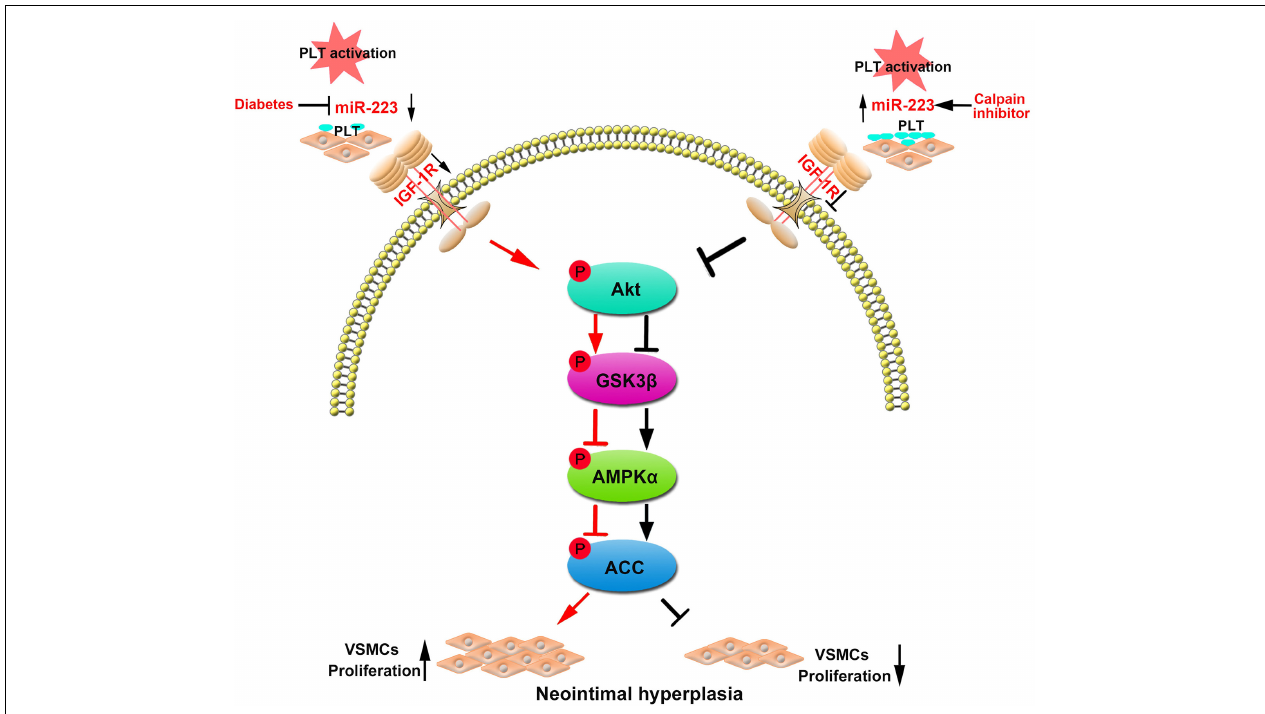
FIGURE 7 | Restoring the platelet miR-223 by calpeptin alleviates the neointimal hyperplasia in diabetes through miR-223/IGF-1R/AMPK signaling pathway. MiR-223 deficiency in diabetic platelet failed to suppress VSMC proliferation during vascular injury. The platelet-derived miR-223 suppressed VSMC proliferation via the regulation IGF-1R/AMPK signaling pathways. Interestingly, treating with a calpeptin restores the downregulated expression of miR-223 in diabetic platelets to suppress VSMC proliferation via targeting IGF-1R and plays a protective role in diabetic neointimal